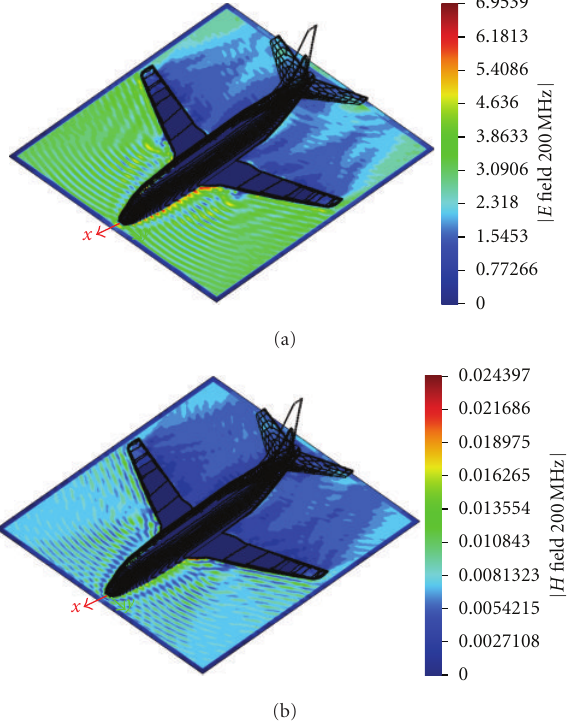
Figure 9: Smooth contour fill of near-field distribution in fre- quency domain on z = 0 . 05 plane, (a) E field distribution, and (b) H field distribution. Table 3: Comparisons of computation time.